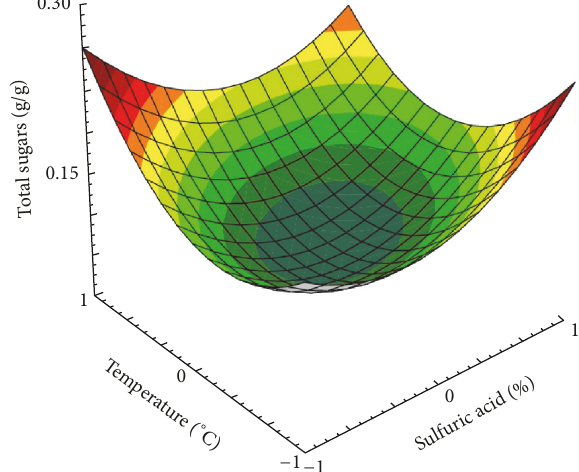
Figure 1: Influence of temperature ( ∘ C) and diluted sulfuric acid concentration (%) on the generation of total sugars.